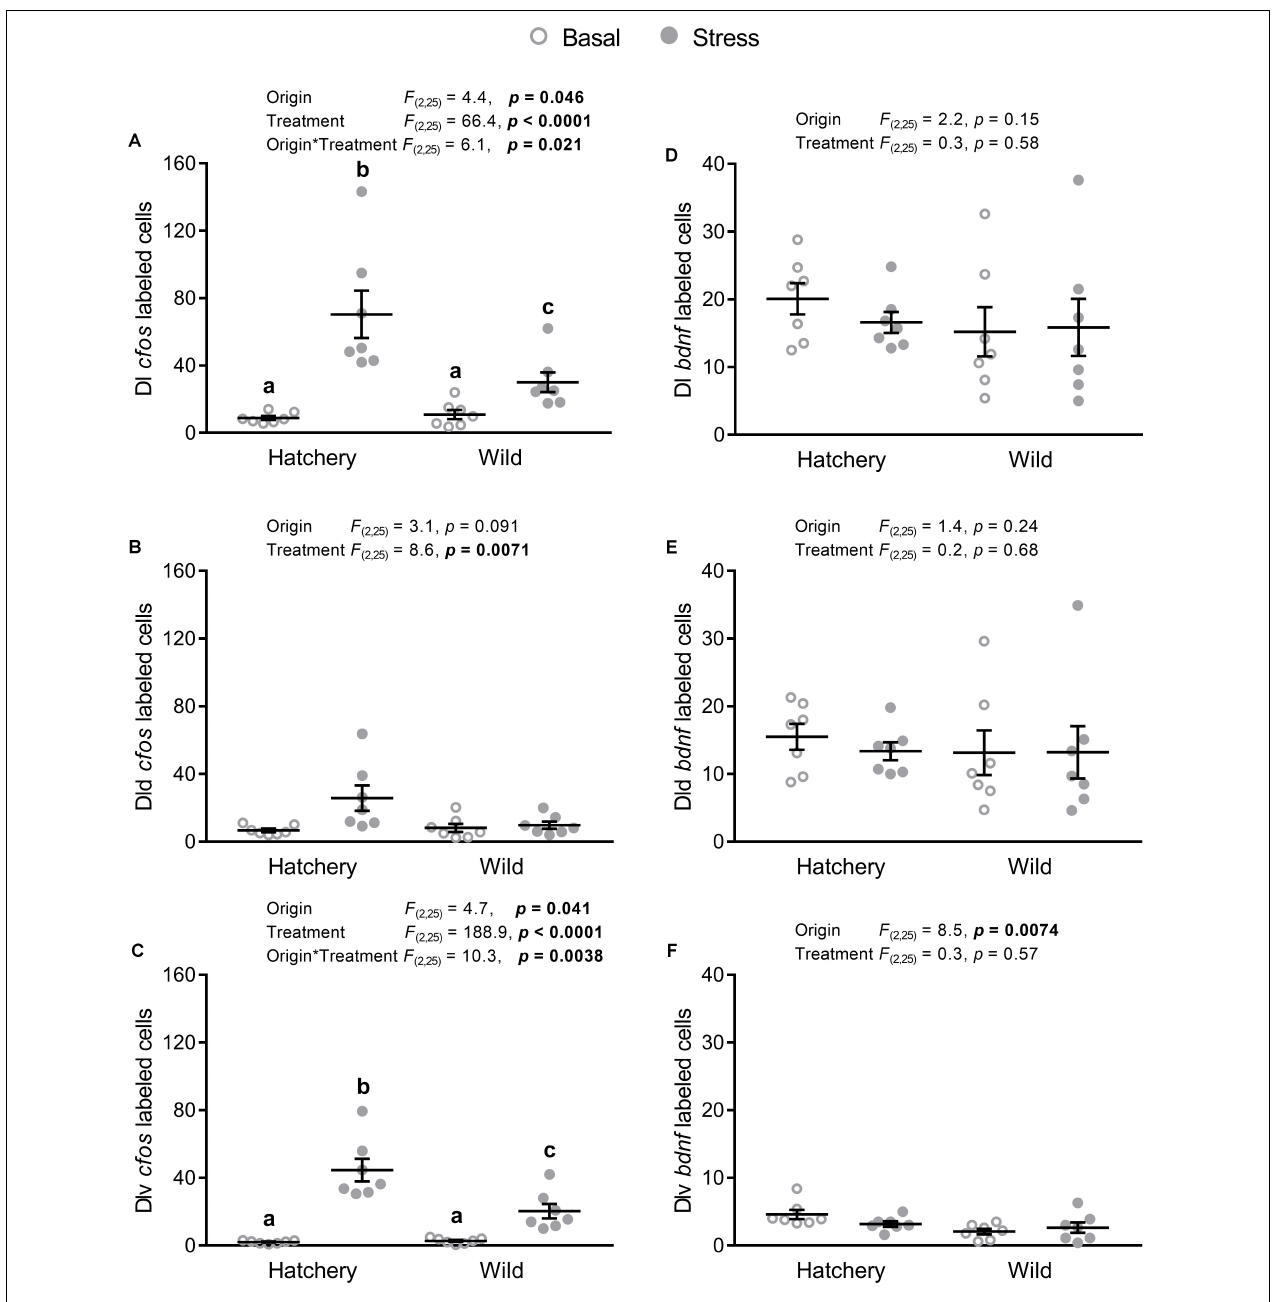
FIGURE 3 | In situ hybridization labeled cfos and bdnf cells in the Dl, Dld, and Dlv. Effect of origin (hatchery vs. wild) and treatment (basal vs. stress) on mean ± SEM expression of cfos (A–C) and brain-derived neurotrophic factor ( bdnf ; D–F ) in the entire (dorsal + ventral) dorsolateral pallium (Dl; A , D ), as well as the dorsal only (Dld; B , E ) and the ventral only (Dlv; C , F ) subregions. Two-way analysis of variance (ANOVA) statistics are displayed in each panel, n = 7 per treatment. Groups that do not share a similar lowercase letter are significantly different from one another (Tukey–Kramer HSD post-hoc